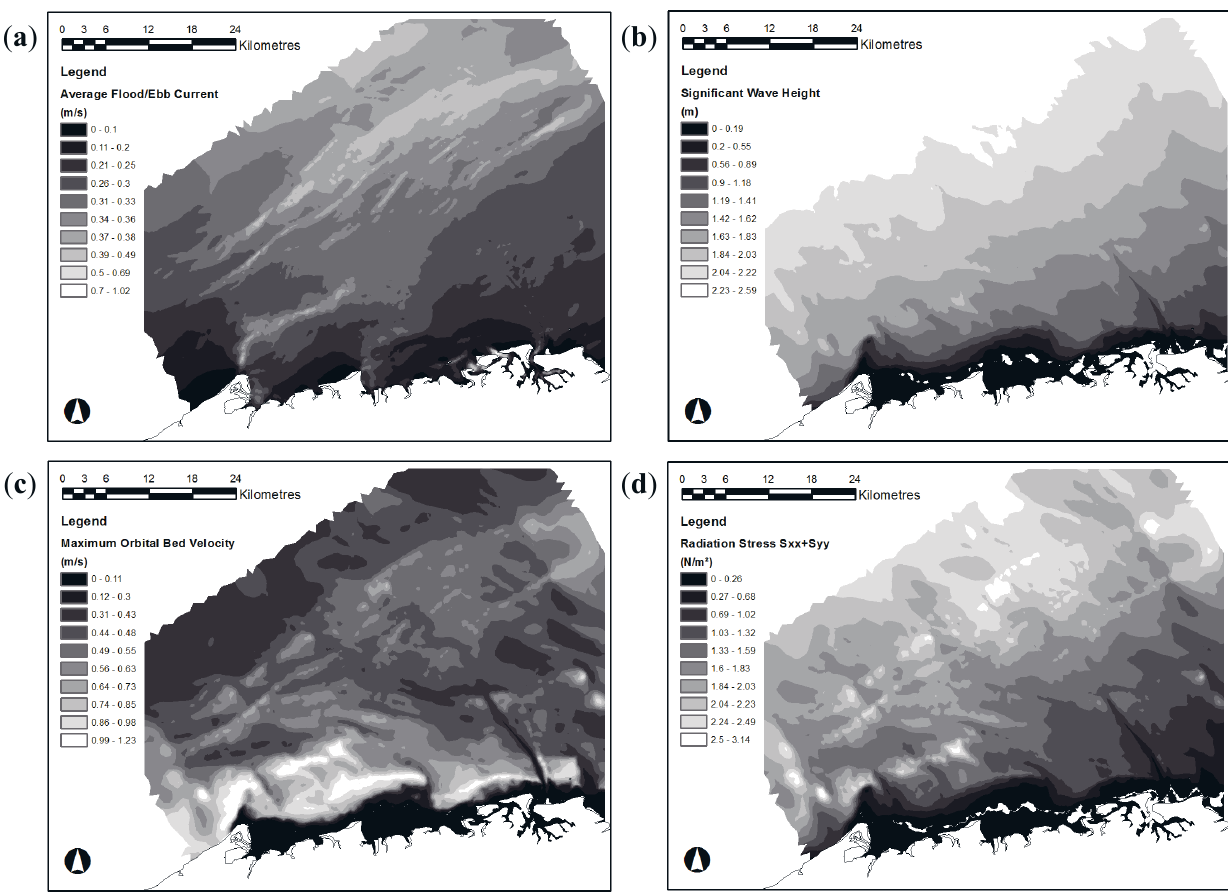
Figure 6. ( a ) Average maximum current speed for both flood and ebb tides. ( b ) Modelled significant wave height from the mean wave direction (north west). ( c ) Maximum orbital velocity of the modelled waves. ( d ) Radiation stresses of the modelled